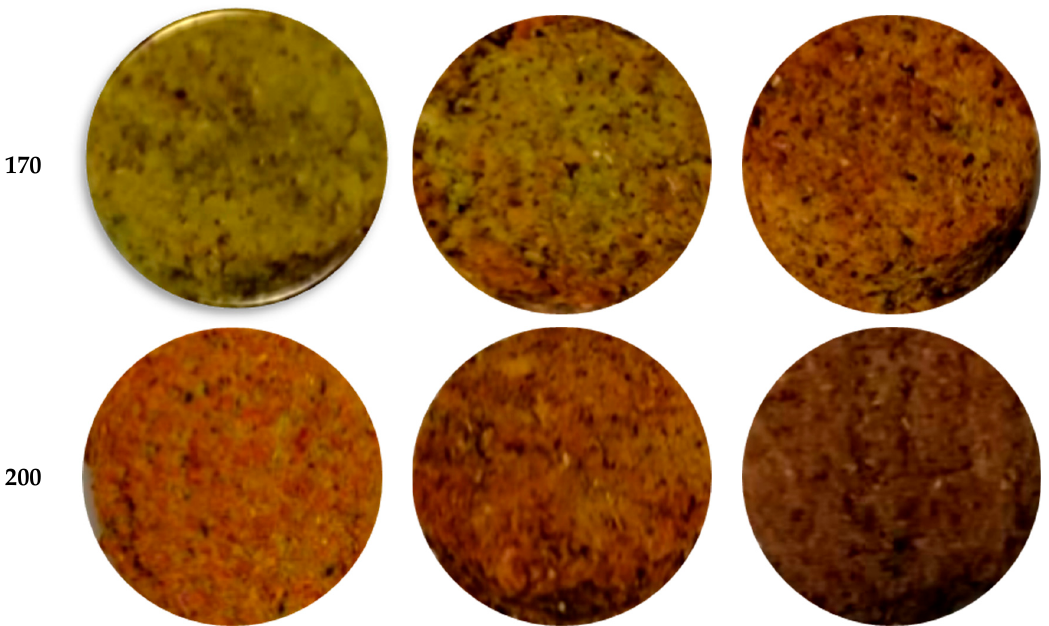
Figure 2. Color alterations of the air-fried falafel in relation to frying temperature and time.